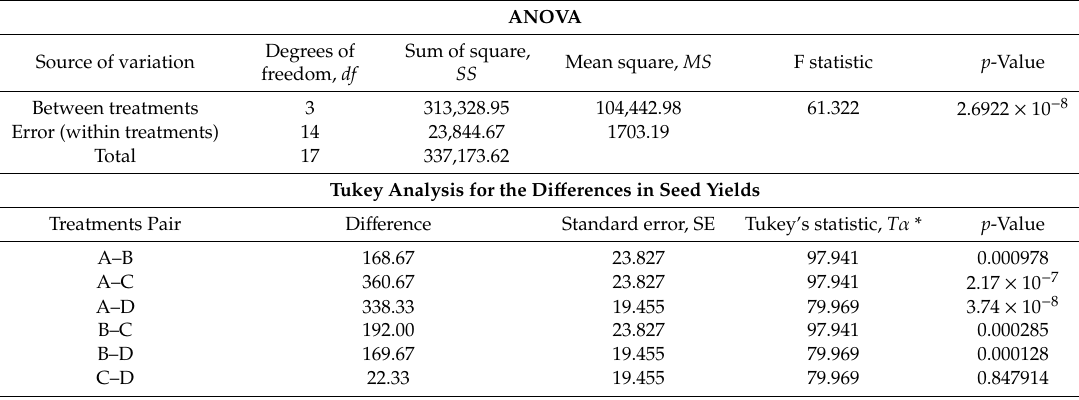
Table 12. ANOVA and Tukey test